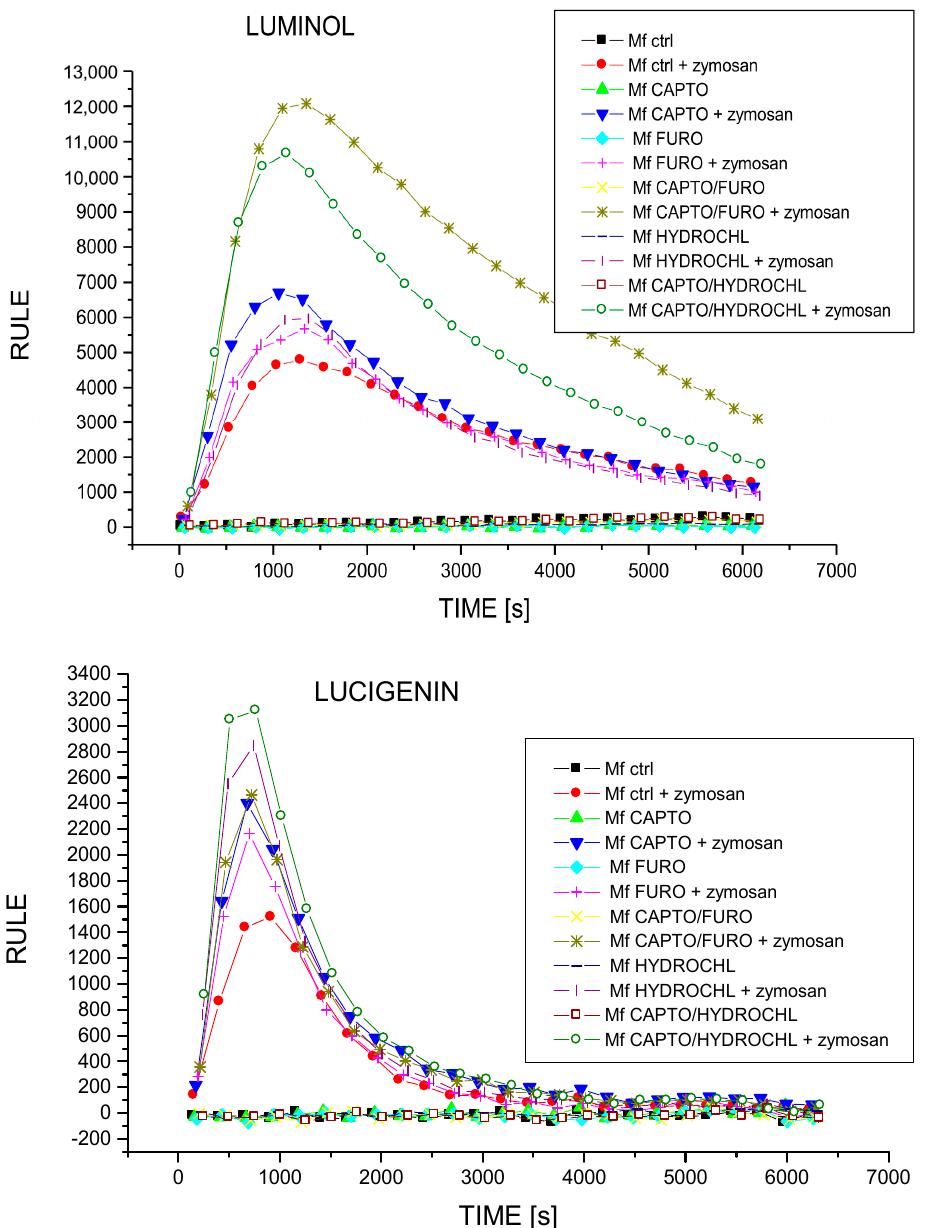
Figure 6. Generation of reactive oxygen intermediates (ROIs) by macrophages harvested from drug-treated mice. Oil-induced peritoneal macrophages from mice treated with captopril with or without a respective diuretic drug were harvested and incubated with luminol or lucigenin, as a chemiluminescent probe, for 15 min at 37 °C. Afterwards, macrophage oxidative burst was stimulated with mouse serum-opsonized zymosan just before the measurement of luminol- or lucigenin-dependent chemiluminescence with a Lucy 1 luminometer, lasting for 75 min. The averaged results of ROI generation were expressed in relative units of luminescence emission (RULE) per second, n = 3, N = 3.